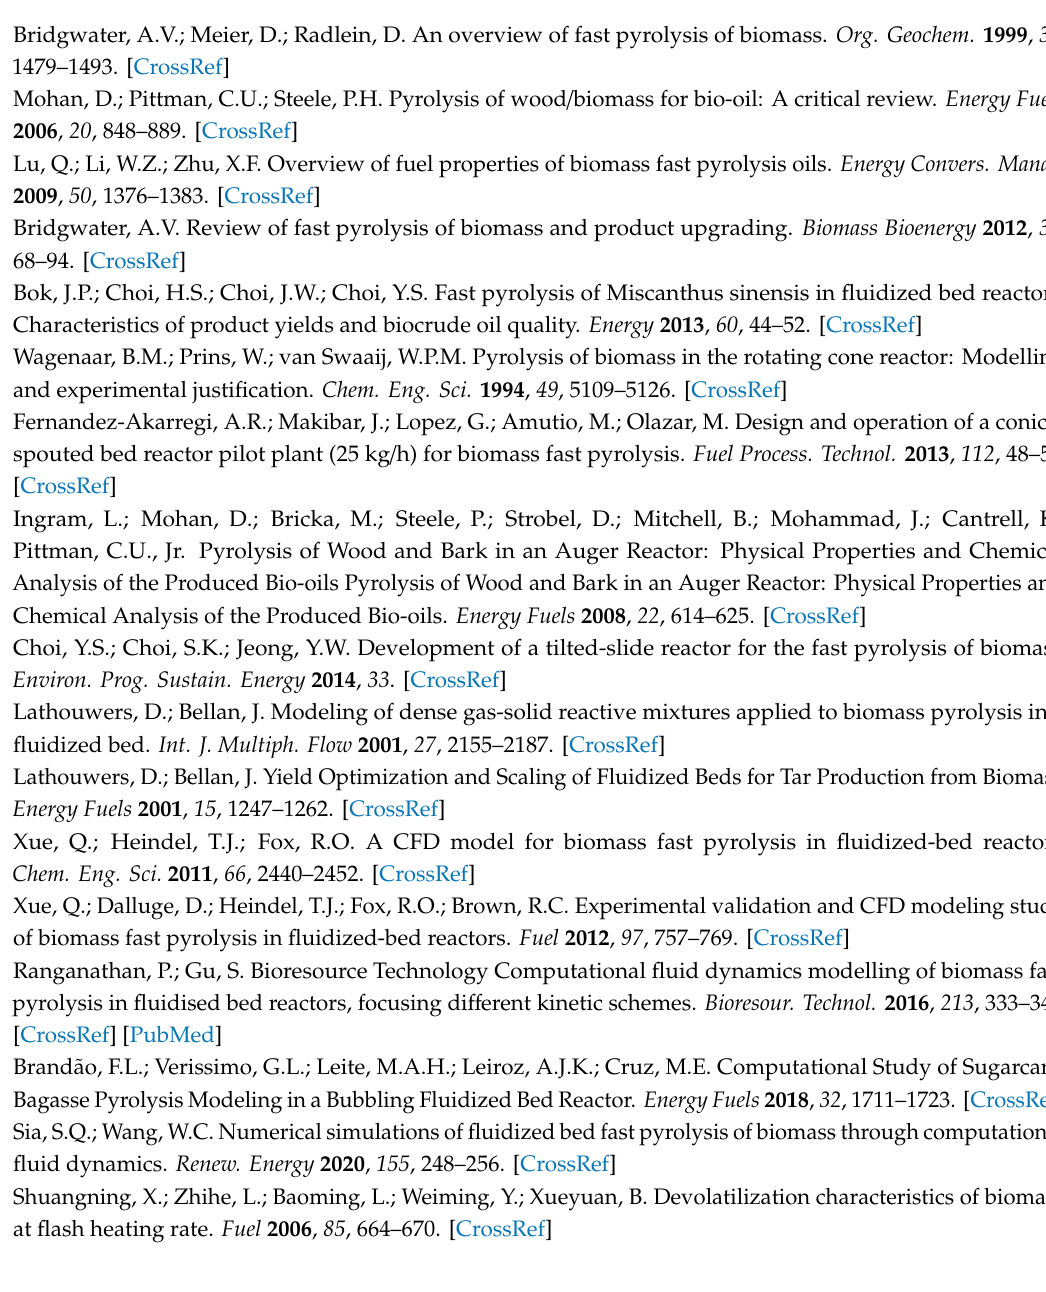
Figure S1: Mass fractions of total volatile and gas species in 1-D plug flow reactor (pfr) in comparison with the mass fractions at the gas outlet in the 3-D reactor simulation with secondary